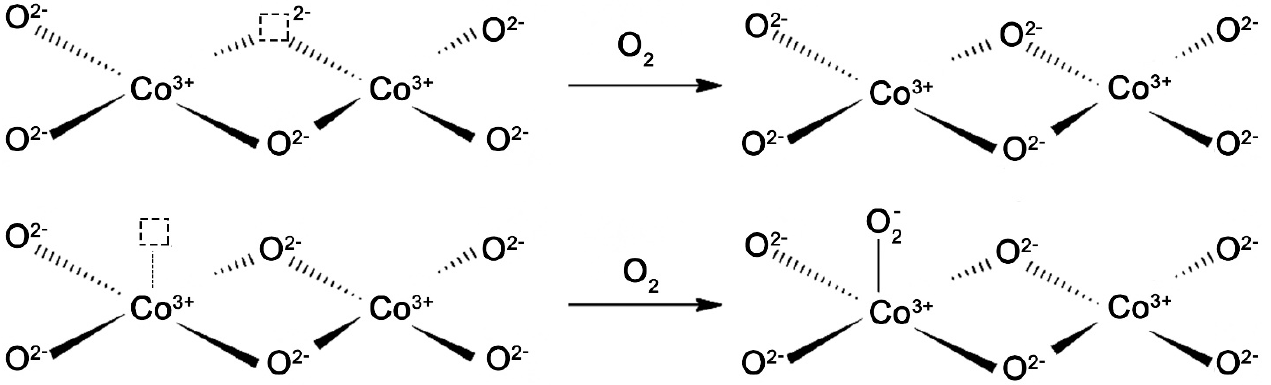
Figure 2. Formation of ROS on the Co 3 O 4 surface.